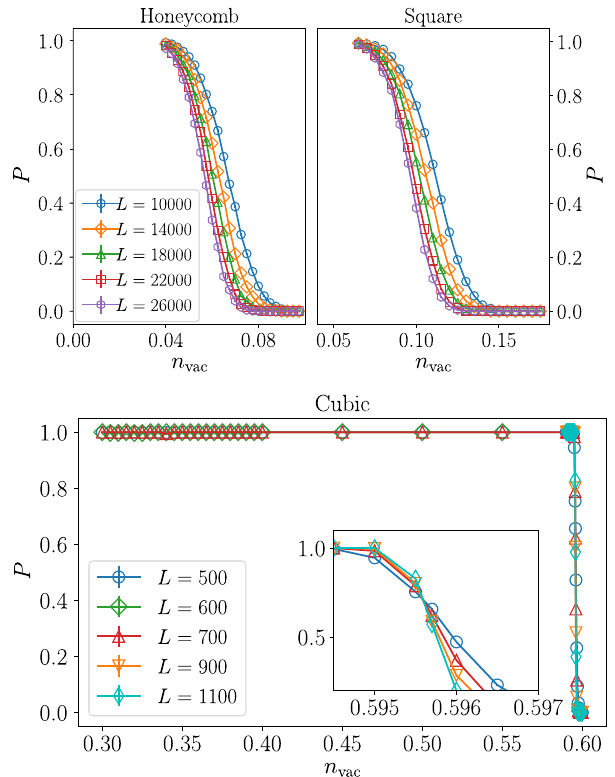
FIG. 10. Probability P that a sample with periodic boundary conditions has at least one R -type region that wraps around the torus in at least one direction. In two dimensions, this tends towards P ¼ 1 in the small- n limit, but curves for different vac sample sizes L never cross each other at any nonzero n vac accessible to our numerical work. In contrast, for the cubic lattice, ≈ 0 . 6 , with curves of this rises sharply to P ≈ 1 around n vac different sizes crossing one another at a sharply defined threshold value. See Sec. VI for